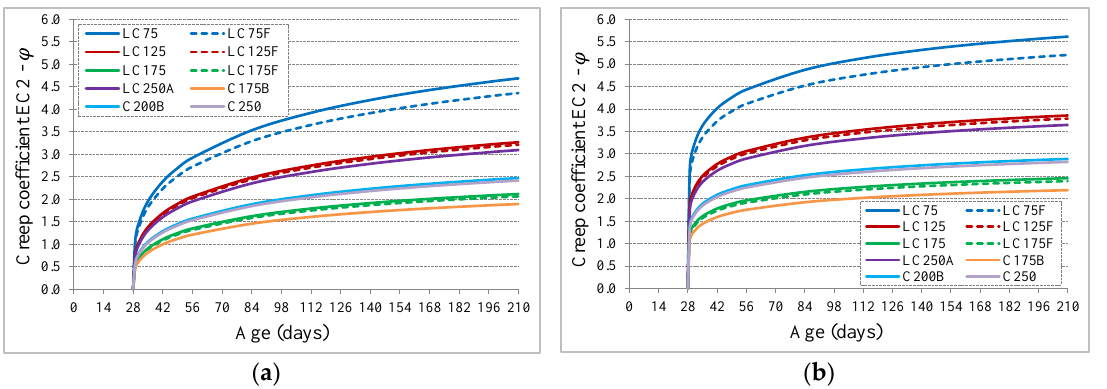
Figure 7. Predicted evolution with age of creep coefficient (EC2): ( a ) curves with αt = 0.30; ( b ) curves with αt = 0.15.